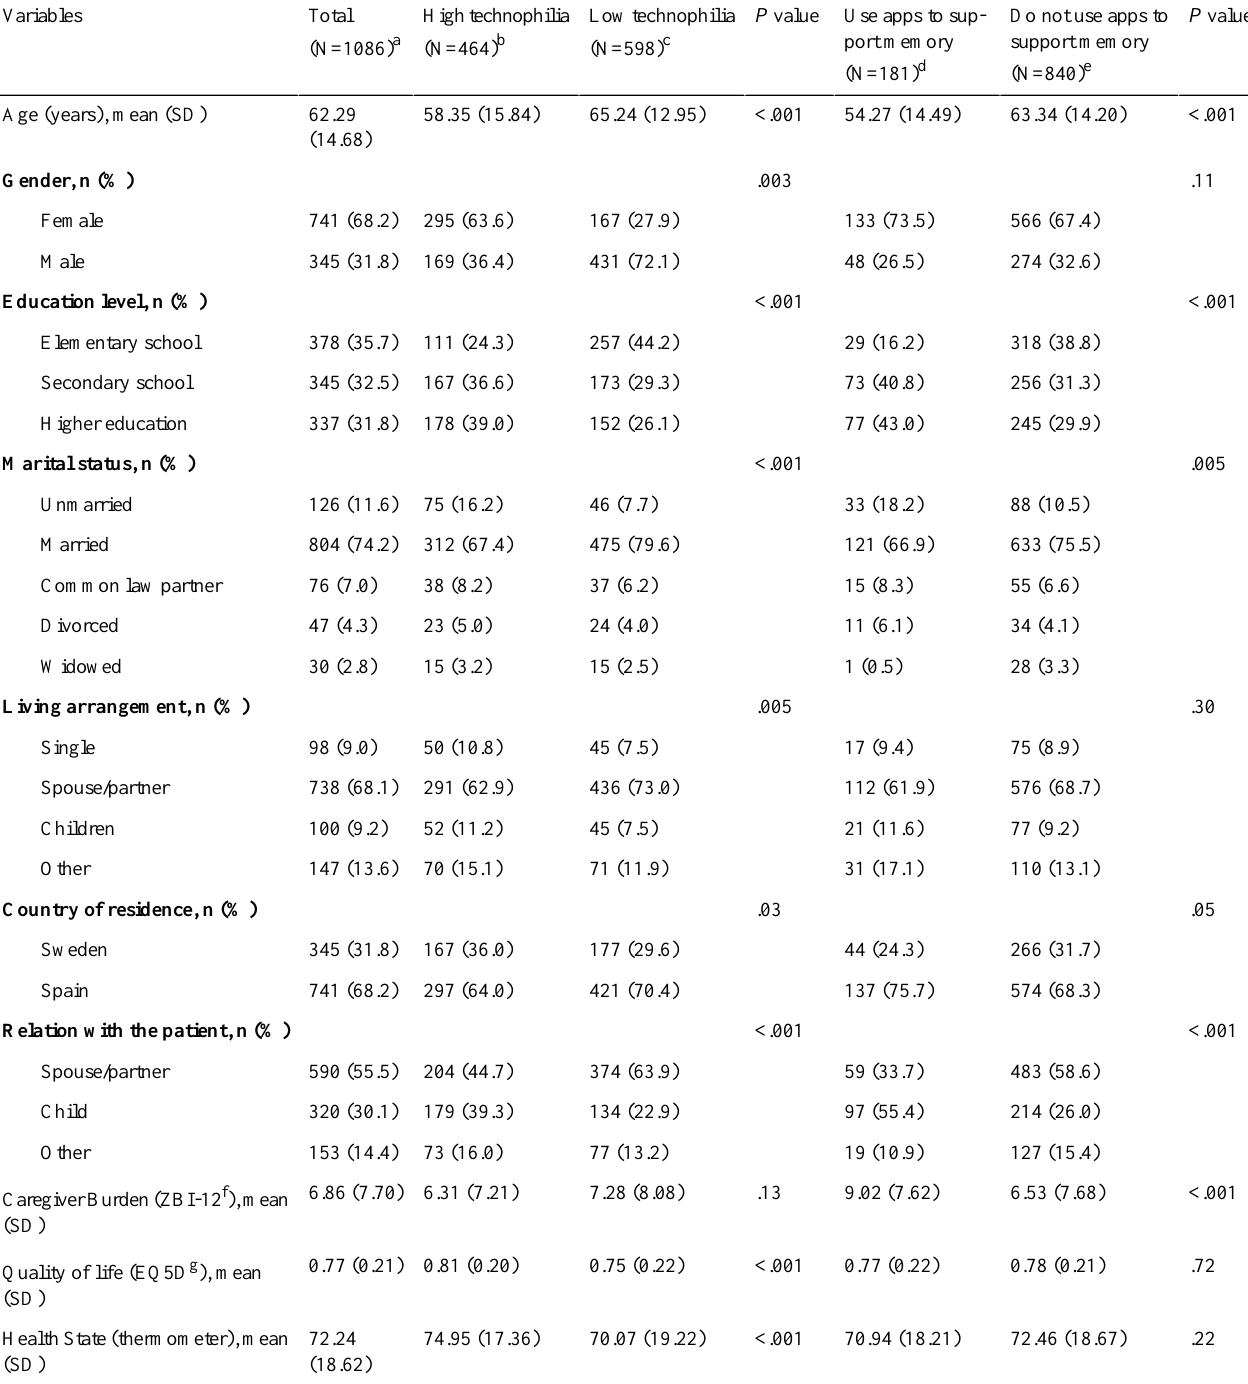
Table 2. Characteristics of caregivers.